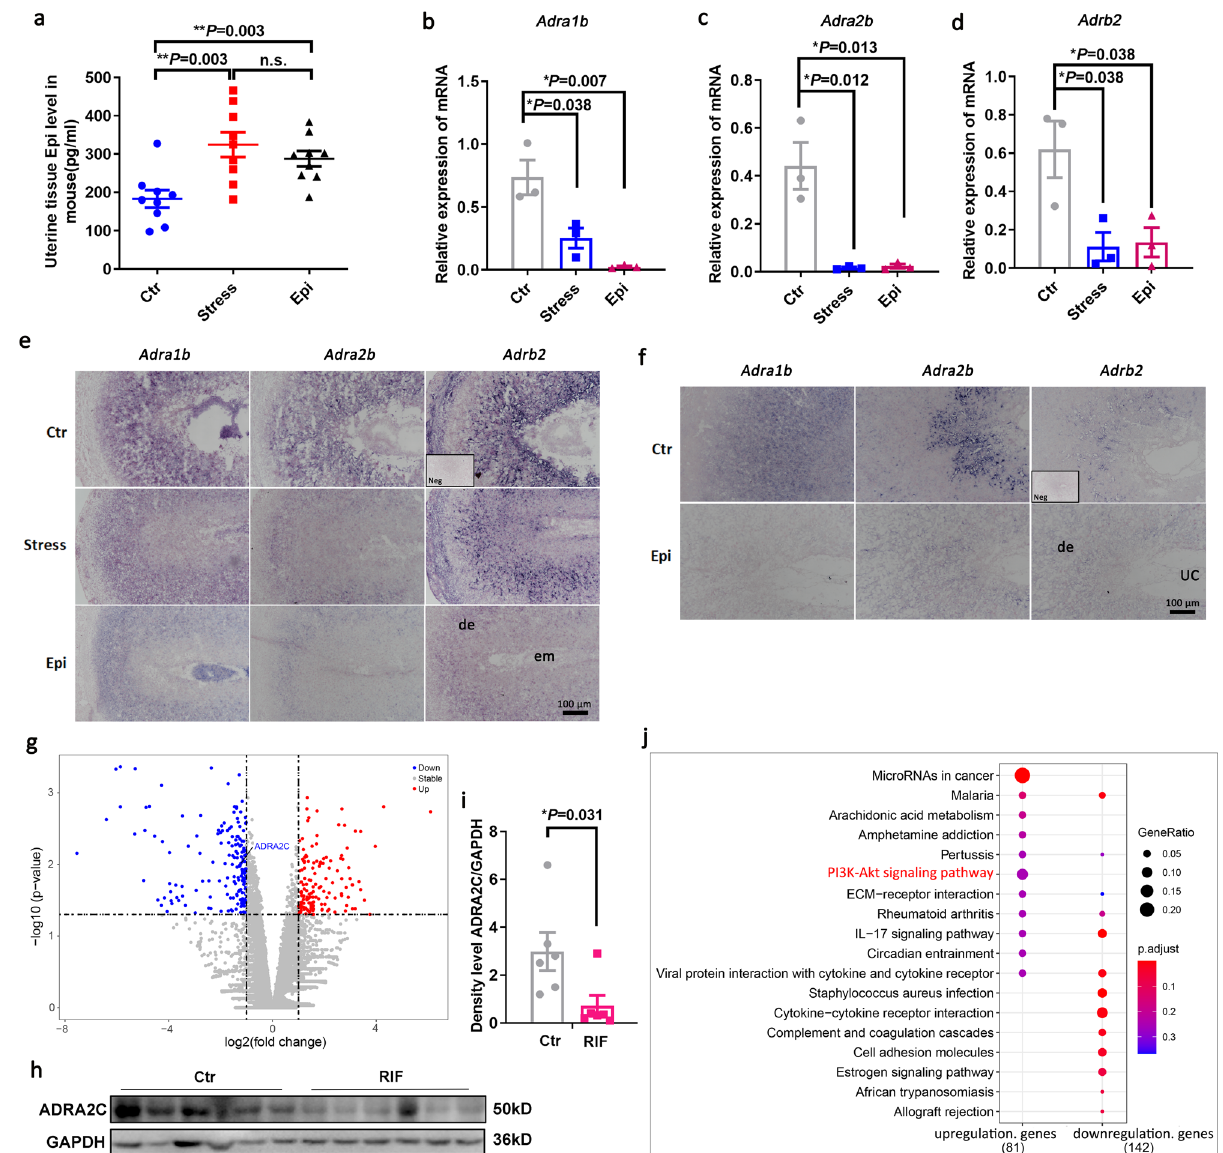
Fig. 7 High level of epinephrine in vivo may alternate adrenergic receptor expression patterns and signaling pathways in mouse and human endometrial tissues. a Comparison of epinephrine at D8 endometrial tissues of mice exposed to exogenous epinephrine ( n = 9) and stressed mice with high serum epinephrine levels ( n = 9) with control mice ( n = 9). b – d qRT-PCR analyses of Adra1b, Adra2b , and Adrb2 at the D8 uteri on stressed mouse and exogenous epinephrine exposed mouse model versus control. e In situ hybridization for expression of Adra1b, Adra2b , and Adrb2 at the D8 uteri on stressed mouse and exogenous epinephrine exposed mouse model versus control. Scale bars, 100 μ m; em embryo, de decidua, Neg negative control. f In situ hybridization revealed the alternation expression of Adra1b, Adra2b , and Adrb2 at the uteri on 96 h exogenous epinephrine exposed pseudopregnancy mouse model versus control. Scale bars, 100 μ m; de decidua, UC uterine cavity, Neg negative control. g Volcano plot of the log2 (fold change) and -log10 ( p value). There were signi fi cant differences in RNA expression between RIF and control endometrial receptive tissues (upregulated genes in red and downregulated genes in blue). h Western blot analysis of ADRA2C expression in mid-secretory phage (LH + 7) endometrial tissues with RIF compared with control. i Density levels of ADRA2C in RIF and control for h . j KEGG pathway analysis of signi fi cantly enriched genes and hub gene counts. For each term, the number of enriched genes was indicated by the dot size, while the level of signi fi cance was represented by the color. Blue indicates low signi fi cance while red represents high signi fi cance (adjust P <